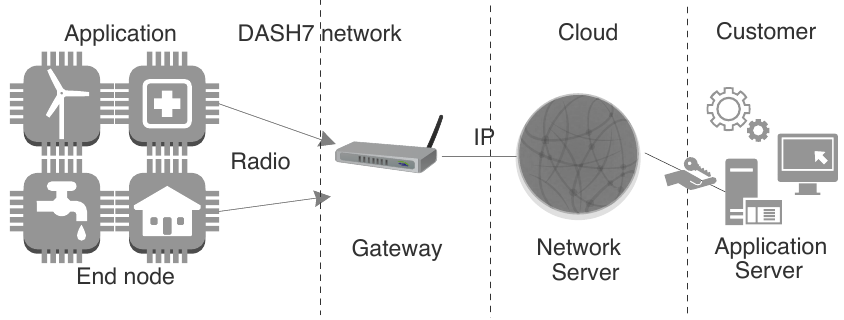
Figure 9. DASH7 network architecture.